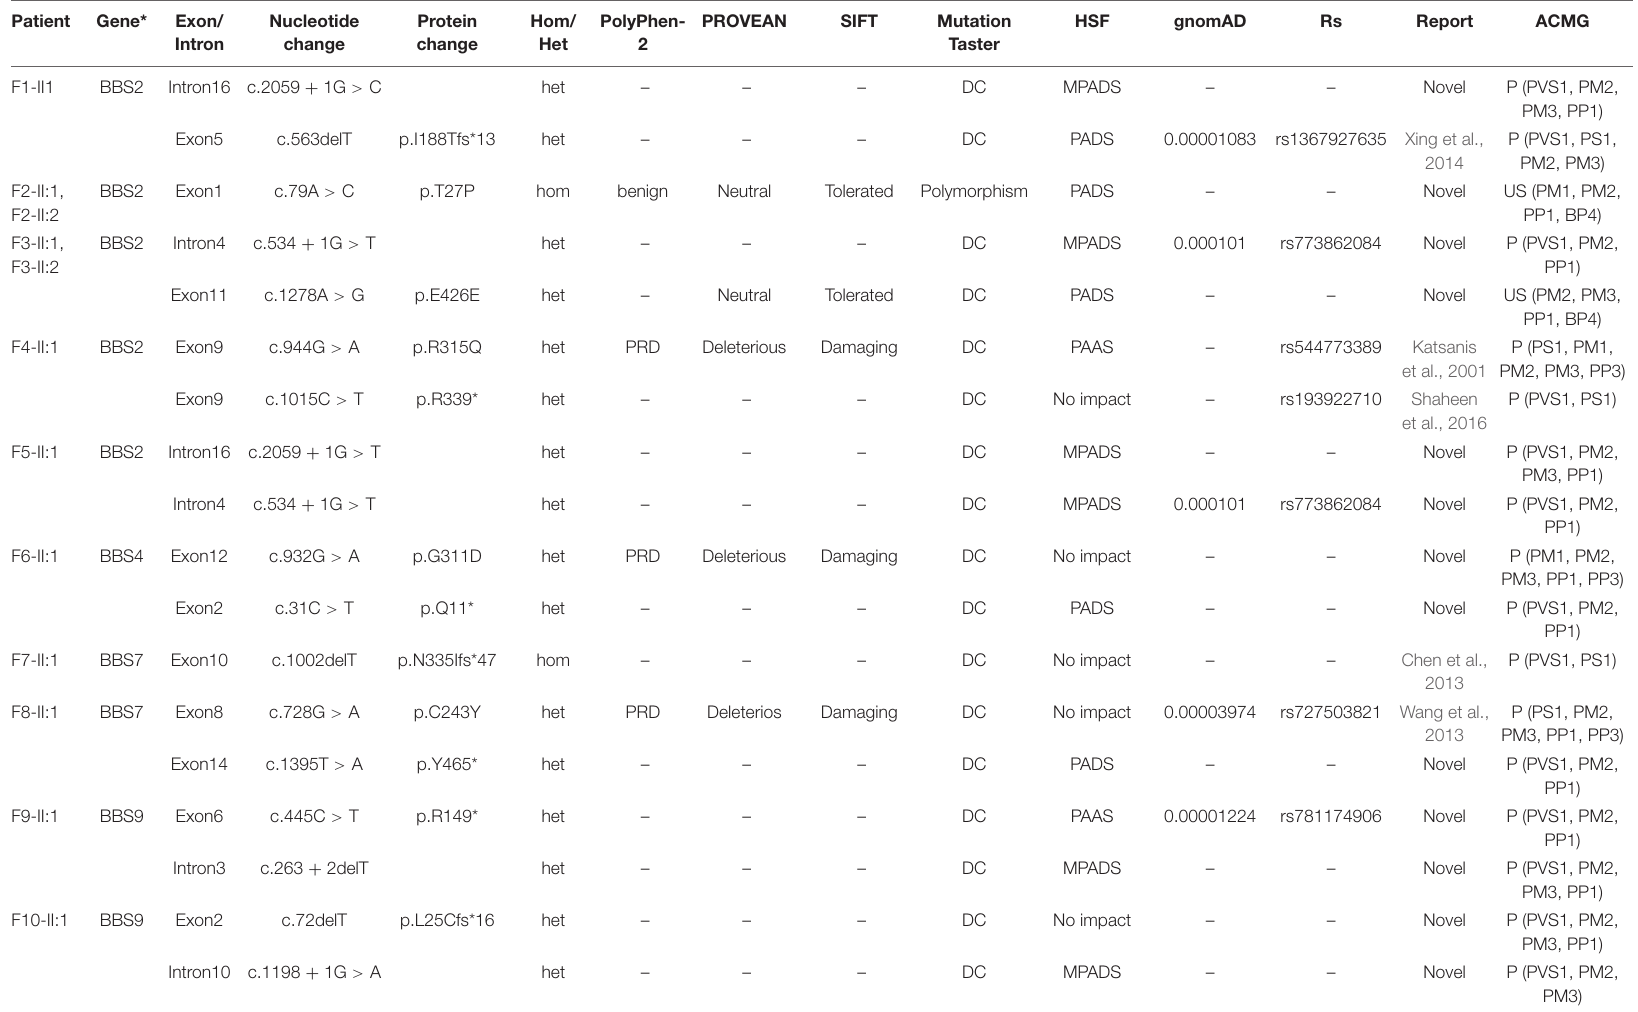
TABLE 3 | Identified variants in patients with BBS. Patient